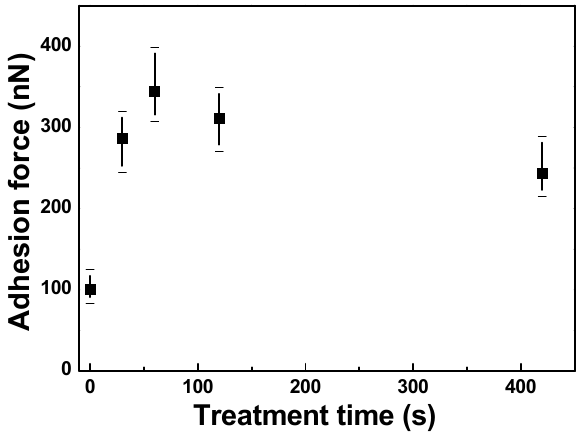
Figure 2. Adhesion force between F-doped ZnO (FZO) films and PI substrates as a function of O 2 plasma pretreatment time.